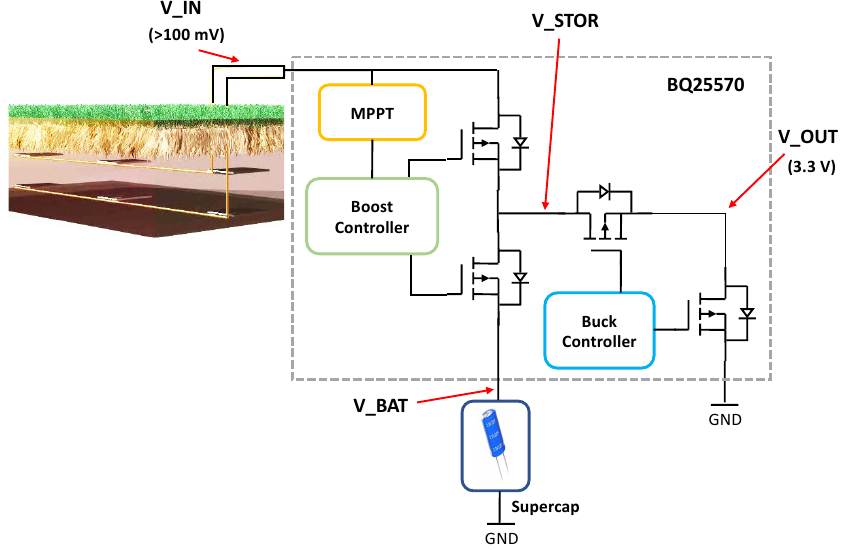
Figure 6. Energy harvesting circuit with the